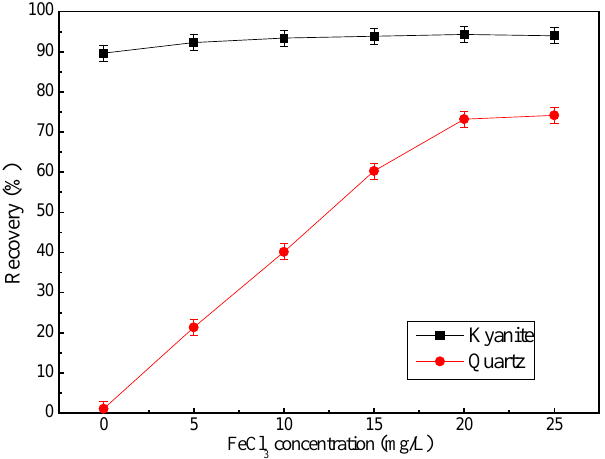
Figure 3. Effect of FeCl 3 concentration on flotation behavior of single minerals.